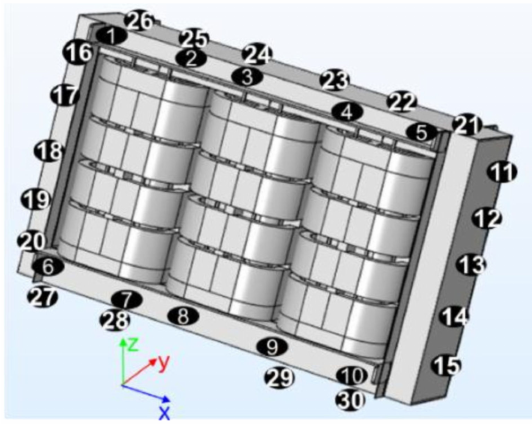
Figure 1. Amorphous alloy transformer model.